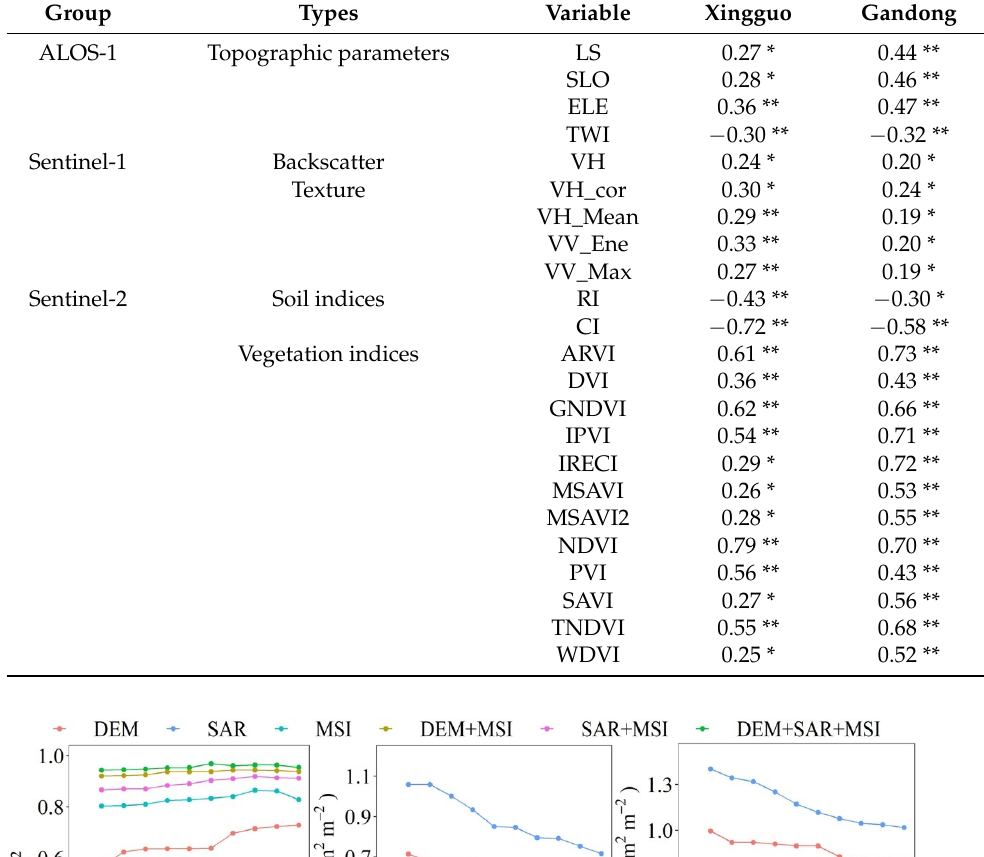
Table 4. Correlation coefficients for the measured LAI and selected variables derived from the ALOS-1 and Sentinel-1 and 2 datasets. ** and * indicate cases with p values below 0.01 and 0.05, respectively.